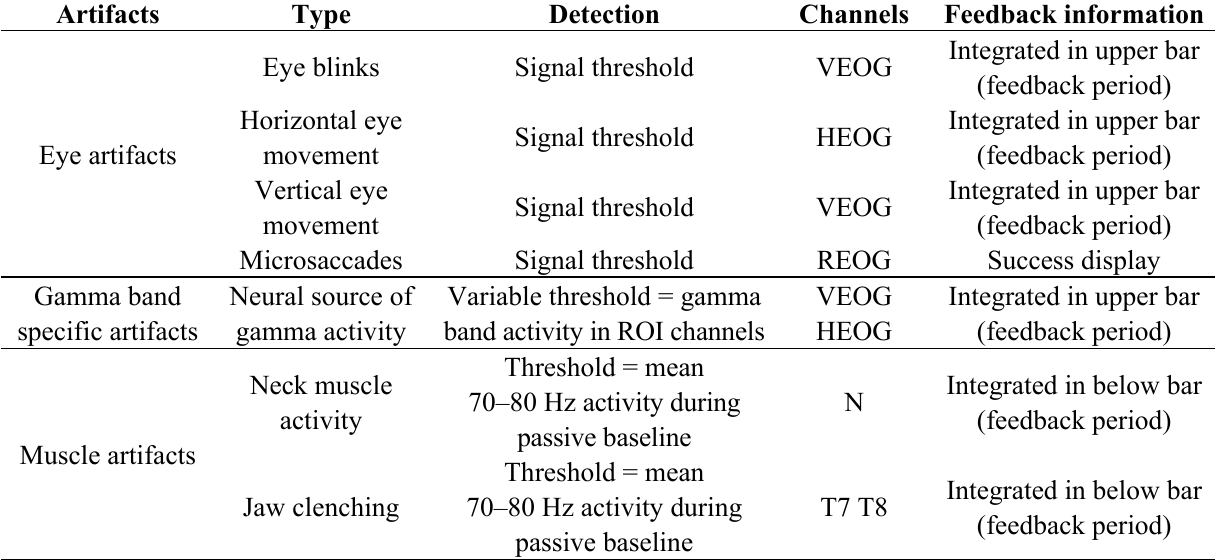
Table 1. Overview of detected artifact